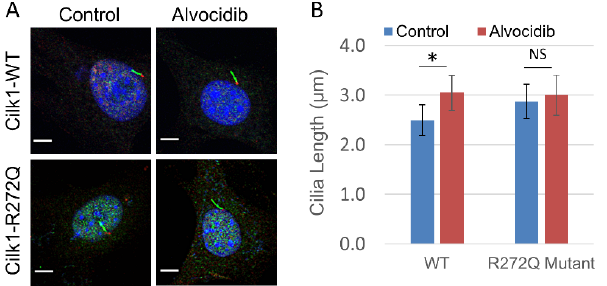
Figure 4. Alvocidib effect on cilia length in wild type and Cilk1 R272Q mutant cells. ( A ) Wild type (WT) or the R272Q mutant mouse embryonic fibroblasts (MEFs) were treated with either DMSO control or Alvocidib (100 nM) for 4 h, fixed, and then co-immunostained for the cilium body (anti-Arl13B, green), the cilium base (anti- γ -tubulin, red), and the nucleus (DAPI, blue). Scale bar, 3 µ m. ( B ) Quantification of cilia length (mean ± SD) in WT and R272Q mutant MEF cells that were treated with either DMSO control or Alvocidib. WT/control (n = 96 cilia); WT/Alvocidib (n = 75 cilia); R272Q/control (n = 53 cilia); R272Q/Alvocidib (n = 48 cilia). * p < 0.05; NS, not